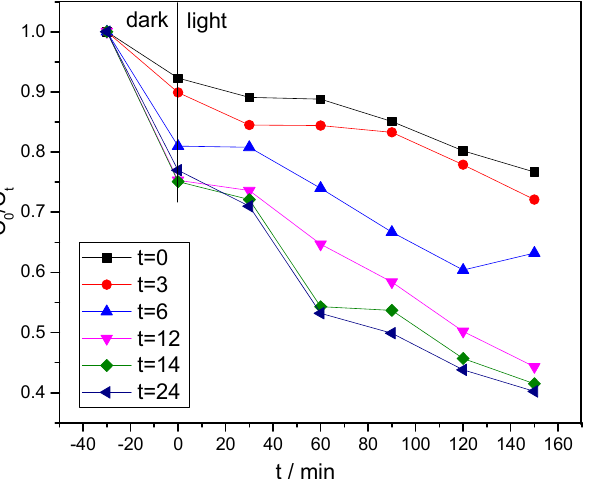
Figure 7. Prediction diagram of the BiVO 4 generation mechanism.